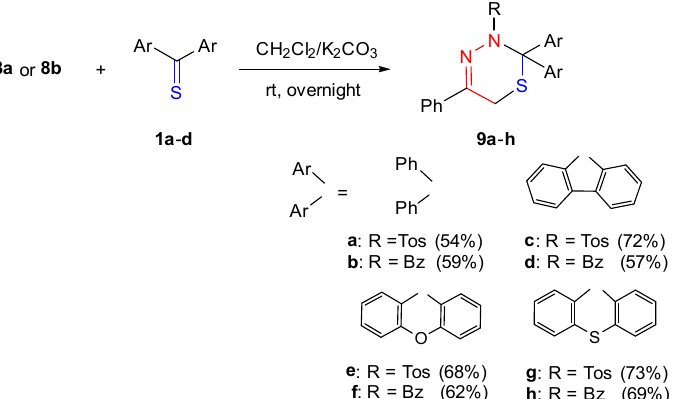
Figure 2. ORTEP Plots [34] of the molecular structures of compounds 9c ( left ) and 9g ( right ). Displacement ellipsoids are drawn at the 50% probability level. Quite unexpectedly, two other aromatic thioketones, namely 2,3,6,7-dibenzocyclo- heptene-1-thione ( 1m ) and its 10,11-dihydro analogue ( 1n ), which have been applied in our earlier studies focused on hetero -Diels-Alder reactions [35], failed to react with 7a even after 3 days at rt and no discoloration of the blue solutions was observed after that time. Ferrocenyl-substituted thioketones 1e – h reacted similarly to aromatic representa- tives, and the reactions carried out at rt in CH 2 Cl 2 with 8a , applied as a precursor of the reactive azoalkene 7a , led to the ferrocenyl substituted 1,3,4-thiadiazine derivatives ( 9i , k , m , o ) in 39–56% yield (Scheme 5). A similar course of the studied reactions, regiose- lectively leading to cycloadducts 9j , l , n , and 9p , was observed with the N -benzoyl func- tionalized azoalkene 7b . In this series, the lower yields of isolated products 9 can be ex- plained by the fact, that along with the desired (4 + 2)-cycloadducts, substantial amounts (40 ‒ 45%) of the corresponding ferrocenyl ketones were formed as side products and iso- lated during chromatographic separation of the crude mixtures as more polar fractions. However, the detailed mechanism of their formation under the applied reaction condi- tions (simple hydrolysis or oxidation of the C=S group) is currently unknown. In accord- ance with the postulated structure of heterocycles 9i – p , the 6-CH 2 group (the H atoms present in this group are diastereotopic in products 9i – p appeared in the 1 H-NMR